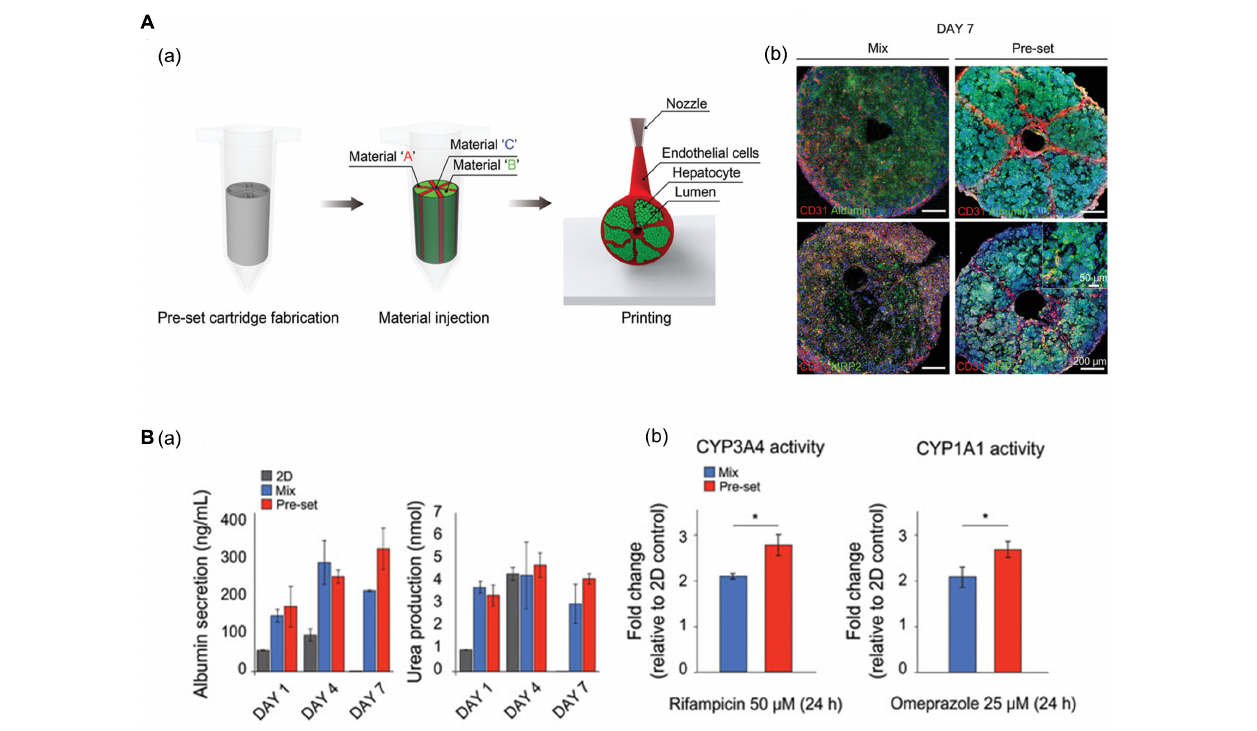
FIGURE 3 | (A) Representative images of vascularized hepatic lobule structure. (a) The schematic of the preset extrusion bioprinting describes the printing strategy for hepatic lobules. (b) Immunofluorescence images of hepatic lobule construct using preset bioprinting exhibit well-preserved structural integrity not seen in the Mix group. (B) Evaluation of hepatic functions. (a) Albumin secretion and urea production measured by ELISA are enhanced in the printed hepatic lobule. (b) CYP3A4 and CYP1A1 enzyme activities are upregulated in printed lobule construct (* p < 0.05). Reprinted with permission from Kang et al.